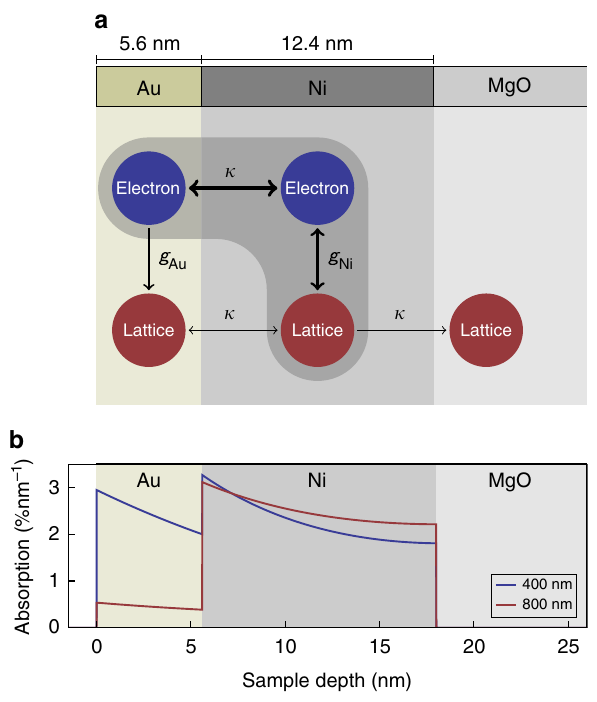
Fig. 1 Schematic of heat reservoirs in the sample structure. a Layer